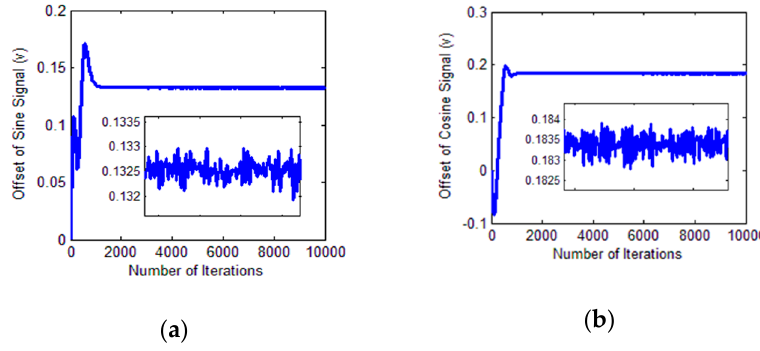
Figure 19. Identification process. ( a ) DC offset of the sine signal; ( b ) DC offset of the cosine signal. The changes in phase shift and loss during training process are shown in Figure 20.